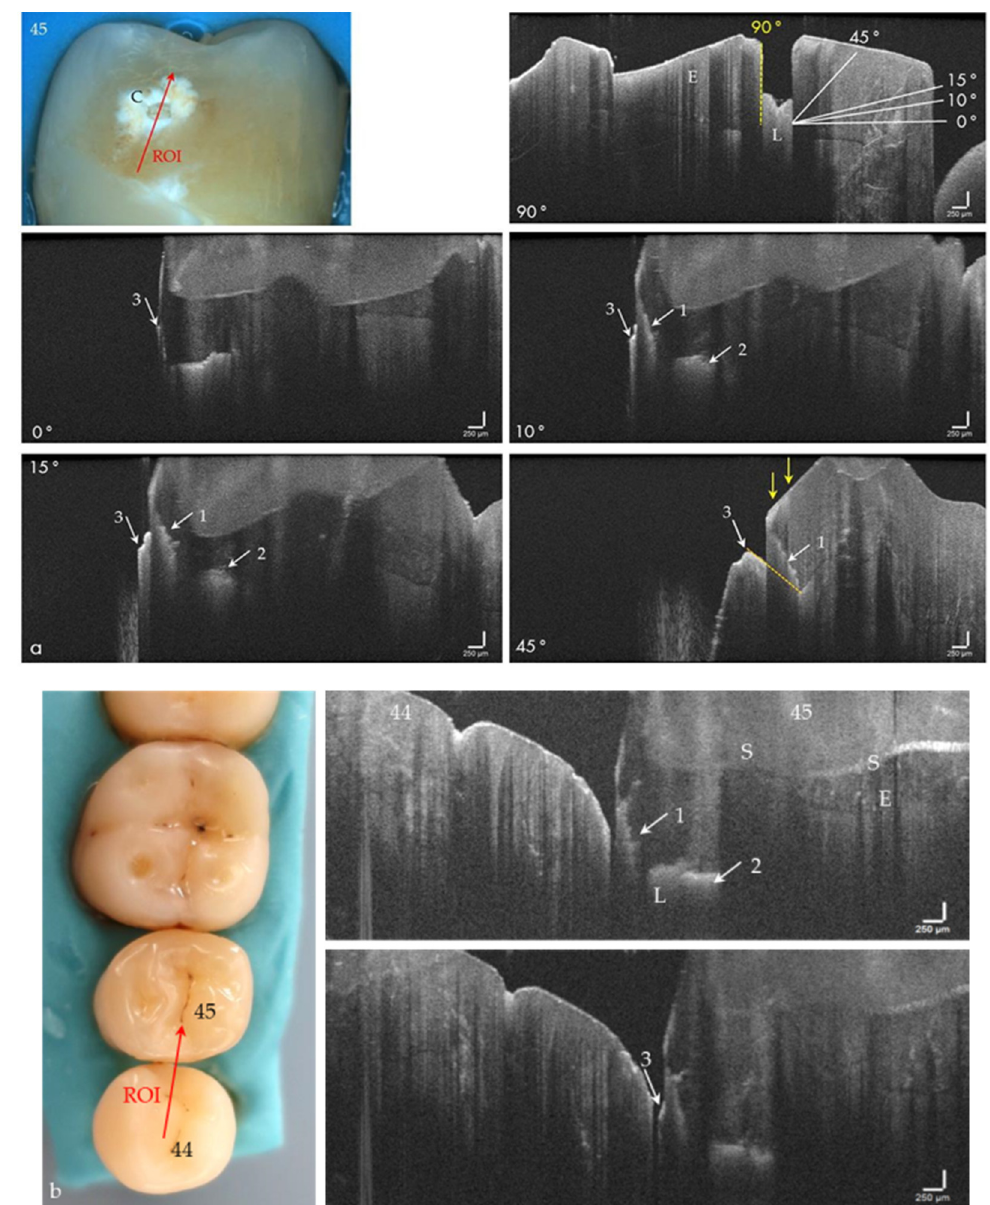
Figure 5. ( a ) Extracted tooth 45 with a cavitated approximal enamel lesion (C). In the OCT image, recorded perpendicular (90°) to the surface, the lesion (L) appeared as a box ‐ shaped structure in the enamel. If the cavitation is imaged from occlusal with an angle of incidence of 0° to 45°, the representation changes. The upper cavity wall appears as a diagonal signal line (arrows 1). Furthermore, the lesion body (arrows 2) and the cervical margin of the cavitation become visible (arrows 3). ( b ) Artificial row of teeth. In the ROI, the diagonal signal of the cavity (arrow 1) merges into a horizontal signal line representing the lesion body extending to the enamel ‐ dentin junction (arrow 2). With a slight variation of the probe position, the protruding edge of the cavity entrance opening appears at some point (arrow 3). When focusing on deeper structures, the tooth surface (S) is inverted in the OCT image. The vertical scales are related to refractive index n = 1.0 (see the remark in Figure. 4). Enamel (E).